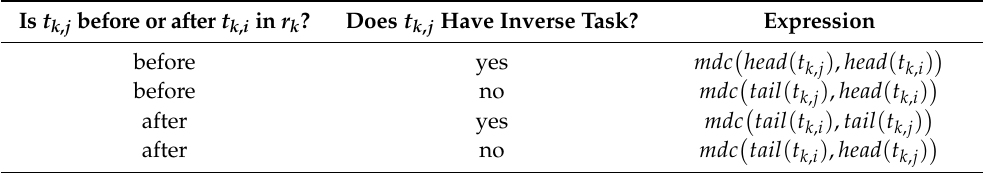
Table 1. Summary table about what expression to use to calculate the distance between an arbitrary arc task t k , j from the route plan r k and t k , i ( i ∈ { s , e } ). Is t k , j before or after t k , i in r k ? Does t k , j Have Inverse Task? Expression before